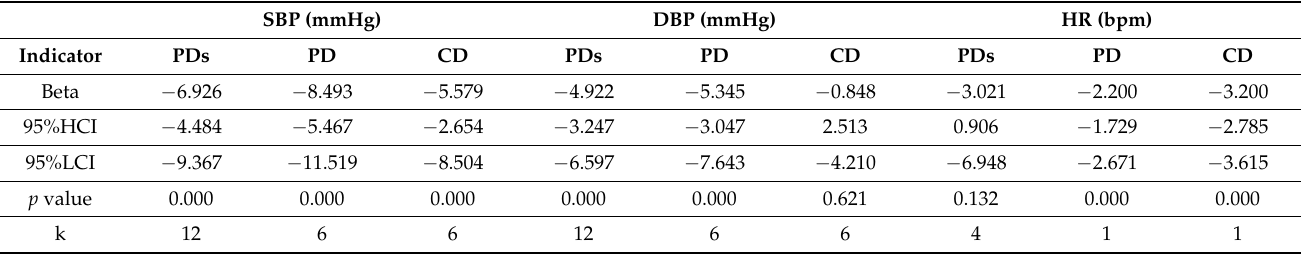
Table 6. Changes in blood pressure (systolic blood pressure, diastolic blood pressure, and heart rate) in short-term PDs, PD, and CD studies (up to 6 months). SBP